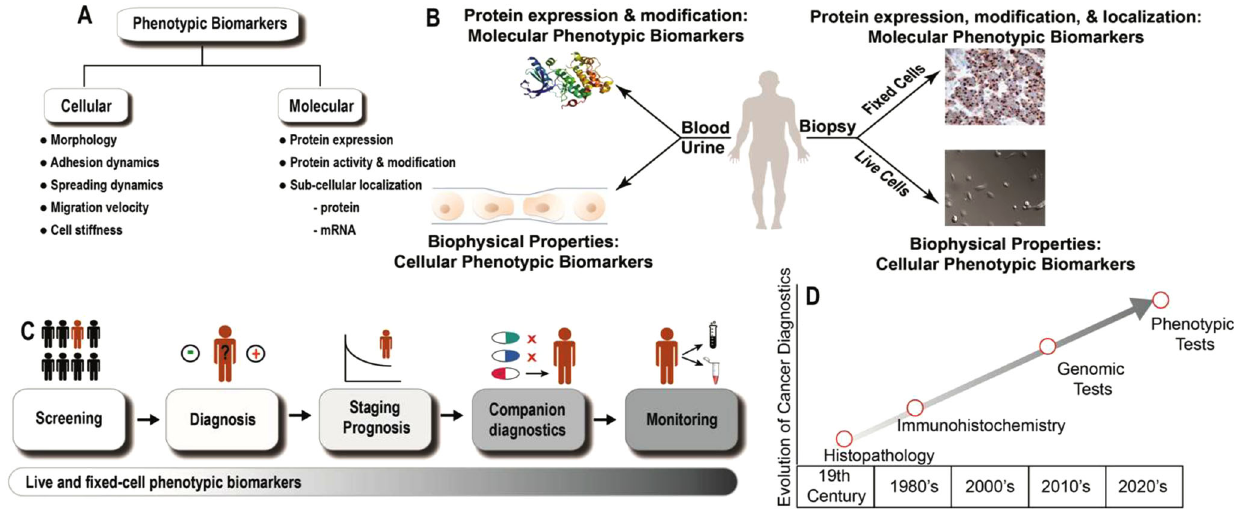
Fig. 1 An overview of phenotypic biomarkers in cancer. a . Revised de fi nition of phenotypic biomarkers: There are two sub-classes of phenotypic biomarkers. Cellular phenotypic biomarkers include non-molecular characteristics of cells such as morphology, adhesion dynamics, spreading dynamics, migration velocity, stiffness, and other biophysical parameters, which can be measured in live-cells. Molecular phenotypic biomarkers include proteins (expression, 10 activity and subcellular localization) and mRNA localization, which can be measured in fi xed-tissue or cells. b . Sources of phenotypic biomarkers for clinical use: Patient biopsy samples can either be immunostained to evaluate molecular phenotypic biomarkers or be used to harvest and culture live-cells to evaluate cellular phenotypic biomarkers. Each individual cell can be further evaluated for molecular phenotypic biomarkers. Body fl uids (blood/urine) are other sources of molecular phenotypic 15 biomarkers. c . Clinical applications of phenotypic biomarkers in cancer management: Phenotypic biomarkers are useful for screening (to identify at-risk individuals); diagnosis (to de fi nitively detect presence of disease); staging and prognosis (to risk stratify and predict disease outcome); companion diagnostics (to predict response to drugs) and for monitoring disease (to evaluate therapeutic response and recurrence). d . Past, present and future of precision can be observed via different modalities such as, but not limited to, next generation sequencing, immuno-histochemistry (IHC), live-cell imaging, and functional magnetic resonance imaging. Each imaging modality, and related modalities employ different probes with their own binding kinetics that dictate the sensitivity and speci fi city of their respective temporal and spatial resolutions, engendering different ideal applications such as screening, diagnostics, prognostics, theranostics (or companion diagnostics), and monitoring, as well as potentially predicating their success in a given application.